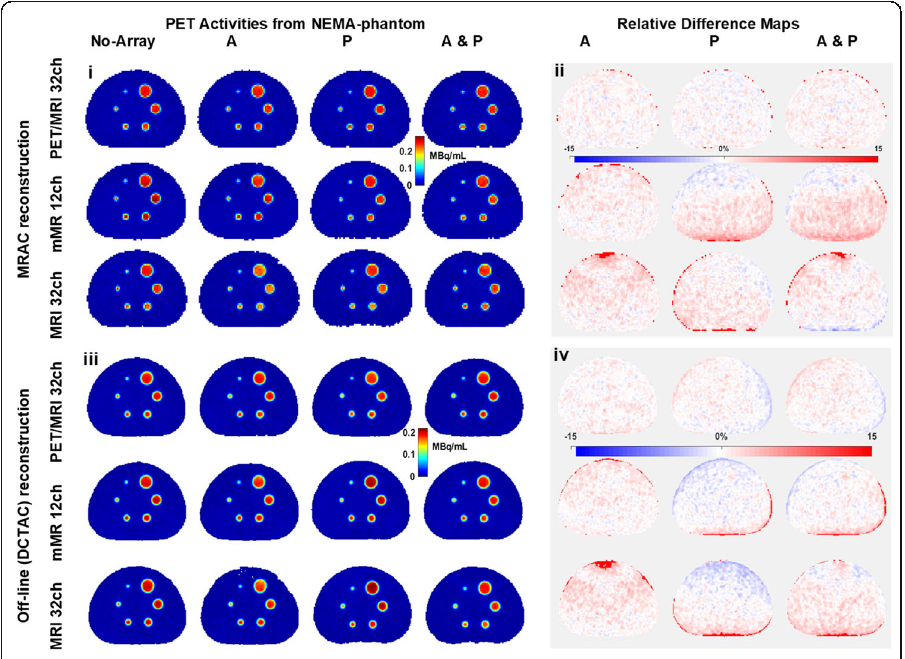
Fig. 3 Reconstructed AC images from all cases (no-array, A, P, A&P) of the NEMA-phantom using both; ( i ) MRAC matrix = 172 × 172 and ( iii ) DCTAC matrix = 344 × 344. The images in ( ii ) and ( iv ) are the RPD maps corresponding to MRAC and DCTAC reconstructions respectively, which are result from the estimated difference between each case (A, P and A&P) with the no-array in a pixel-by-pixel